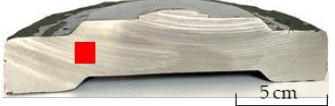
Figure 8. Location of the light microscopy images.